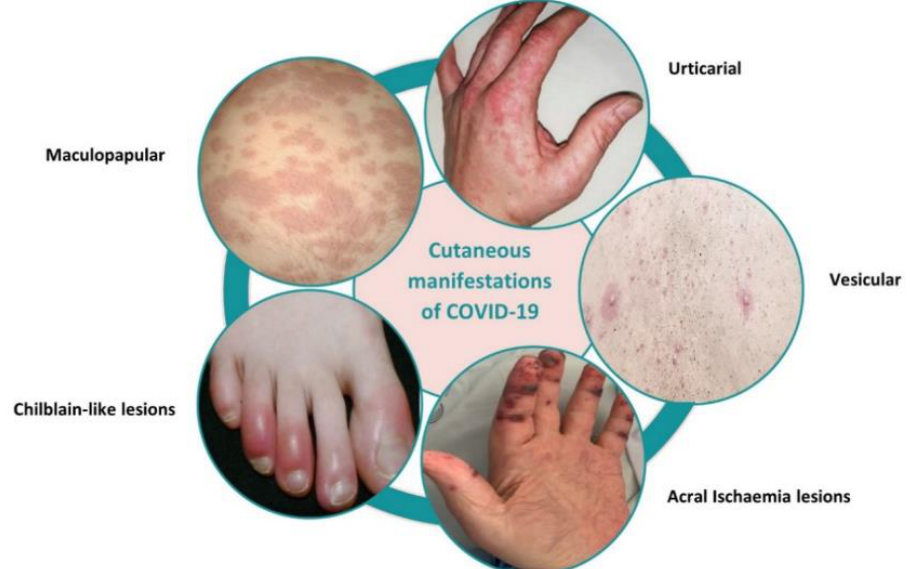
Figure 1. Cutaneous manifestations associated with COVID-19. Adapted with permission from [14,15,18 – 20].